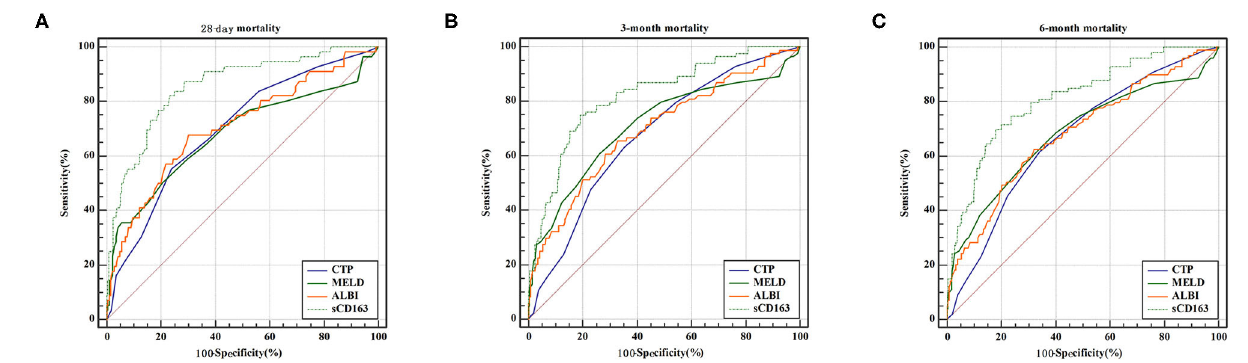
and ALBI scores (difference between areas = 0.144, 95% CI = 0.095–0.192, P < 0.001; difference between areas = 0.118, 95% CI = 0.075–0.161, P < 0.001; difference between areas = 0.138, 95% CI = 0.075–0.202, P < 0.001, respectively).